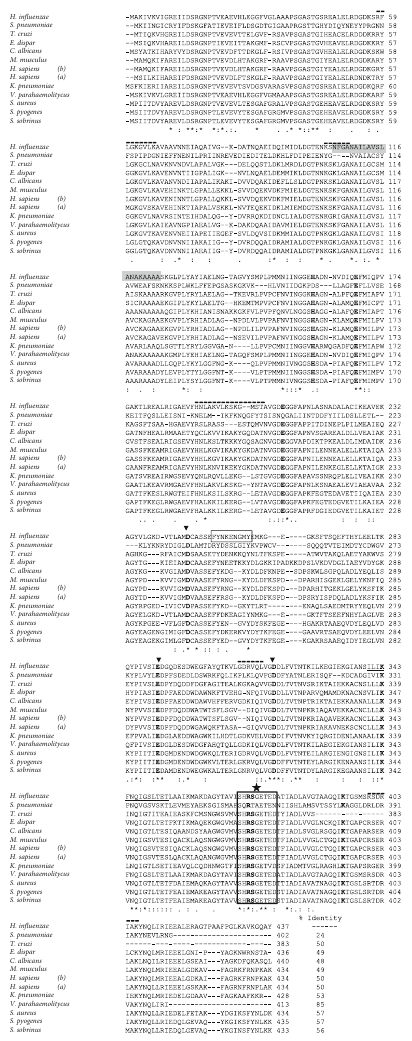
Figure 2: Comparative analysis by alignment of the amino acid sequences of several enolases: Haemophilus in fl uenzae NTHiENO (ASO96723.1), Streptococcus pneumoniae (CTN02995.1), Trypanosoma cruzi (AGR66223.1), Entamoeba dispar (EDR27966.1), Candida albicans (AAA71939.1), Mus musculus (CAA40913.1), Homo sapiens β -enolase (NP_001967.3), Homo sapiens α -enolase (NP_001419.1), Klebsiella pneumoniae (SAW34188.1), Vibrio parahaemolyticus (KZW93652.1), Staphylococcus aureus (BBA234 31.1), Streptococcus pyogenes (AKI77548.1), Streptococcus sobrinus (CAD60544.1); parentheses show GenBank accession numbers. The conserved amino acids in all sequences are labeled with asterisks; the conservative and semiconservative substitutions are labeled with two and one points, respectively. The dashed lines shown gaps introduced between the sequences. The residues involved in Mg 2+ binding are shown in bold and with arrowhead, those forming the enolase signature are underlined, and the motifs for substrate binding are indicated with letters in bold. The putative plasminogen- binding site is boxed. The transmembranal domain is indicated in shadowed gray. The enolase “ fi ngerprint ” motif is boxed and shown with star. RNA-binding motifs are indicated with dashed bold lines over the motive. The percentage of sequence identity between NTHiENO and the enolases from other organisms is indicated at the end of fi